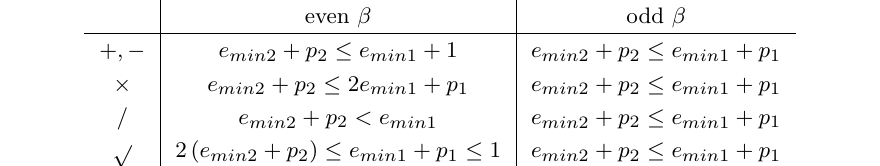
Table III. Hypotheses under which double rounding is innocuous for the FTZ format, in addition to hypotheses of Table I. Division for odd radices is only valid with tie-break